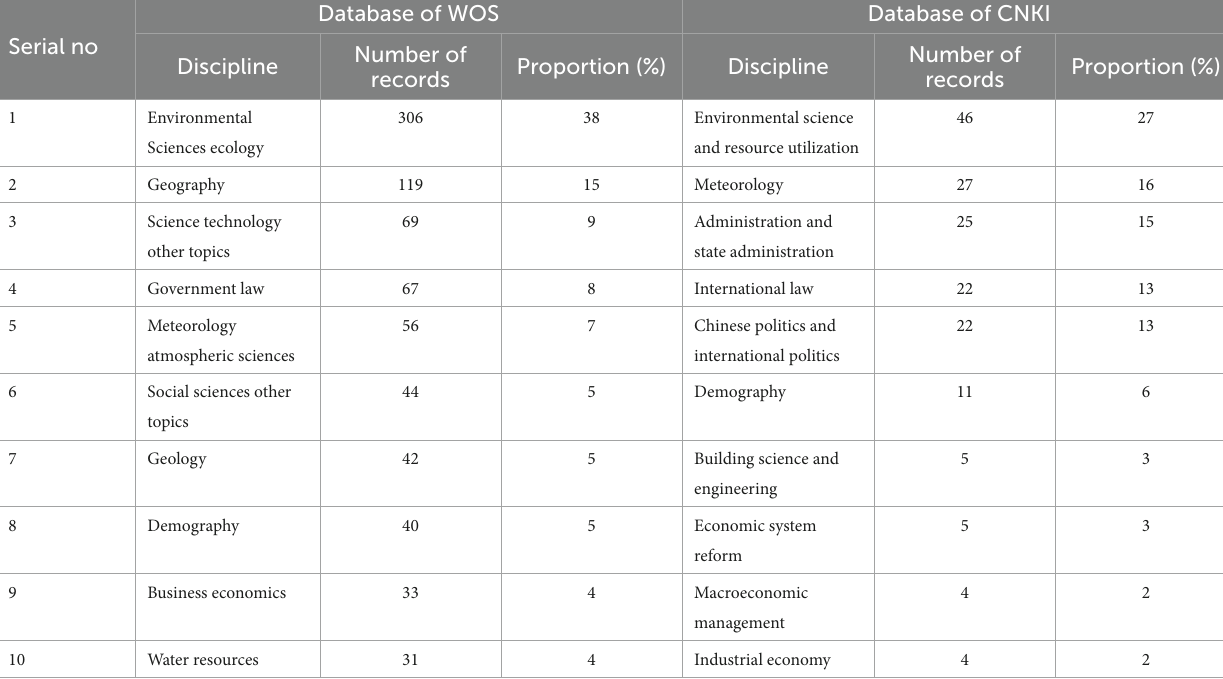
TABLE 2 Statistics of relevant literature on climate migration by discipline